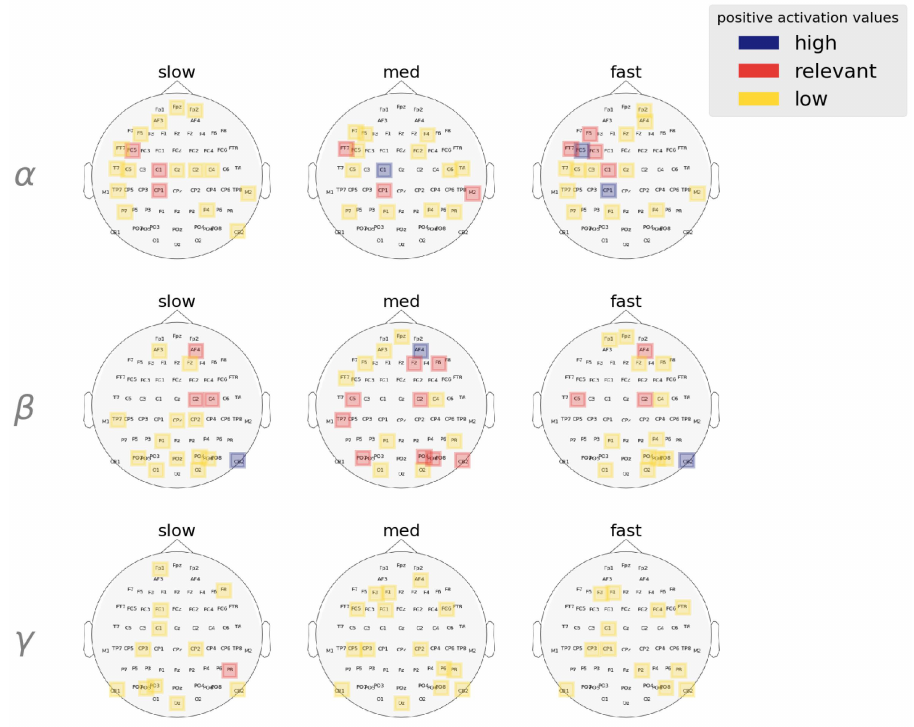
Figure 9. Band-wise spatial features salient to each RT category. Activation values are averaged over all trials and are clustered using GMM to determine high, relevant, and low activation ranges. α and β activation are lateralized in the left and right hemispheres, respectively. Spatial features in the γ bands are mostly deemed irrelevant by the model in describing behavioral RT